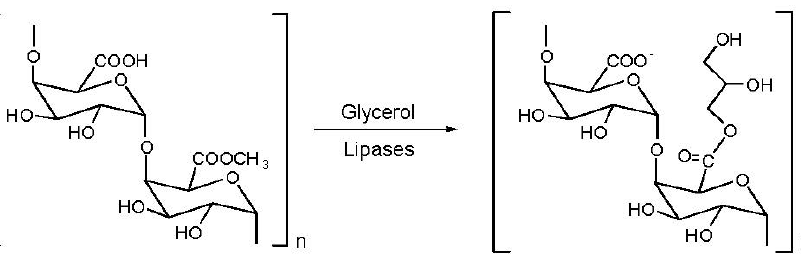
Figure 16. Lipase-catalyzed addition of glycerol to